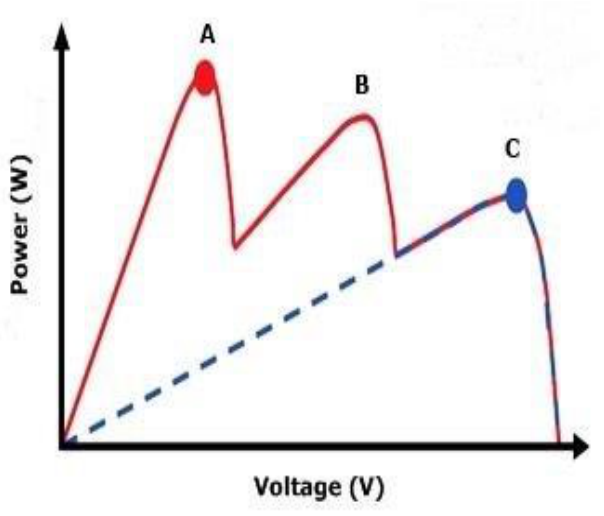
Fig. 2. Electrical characteristics of a solar photovoltaic cell under partial shading